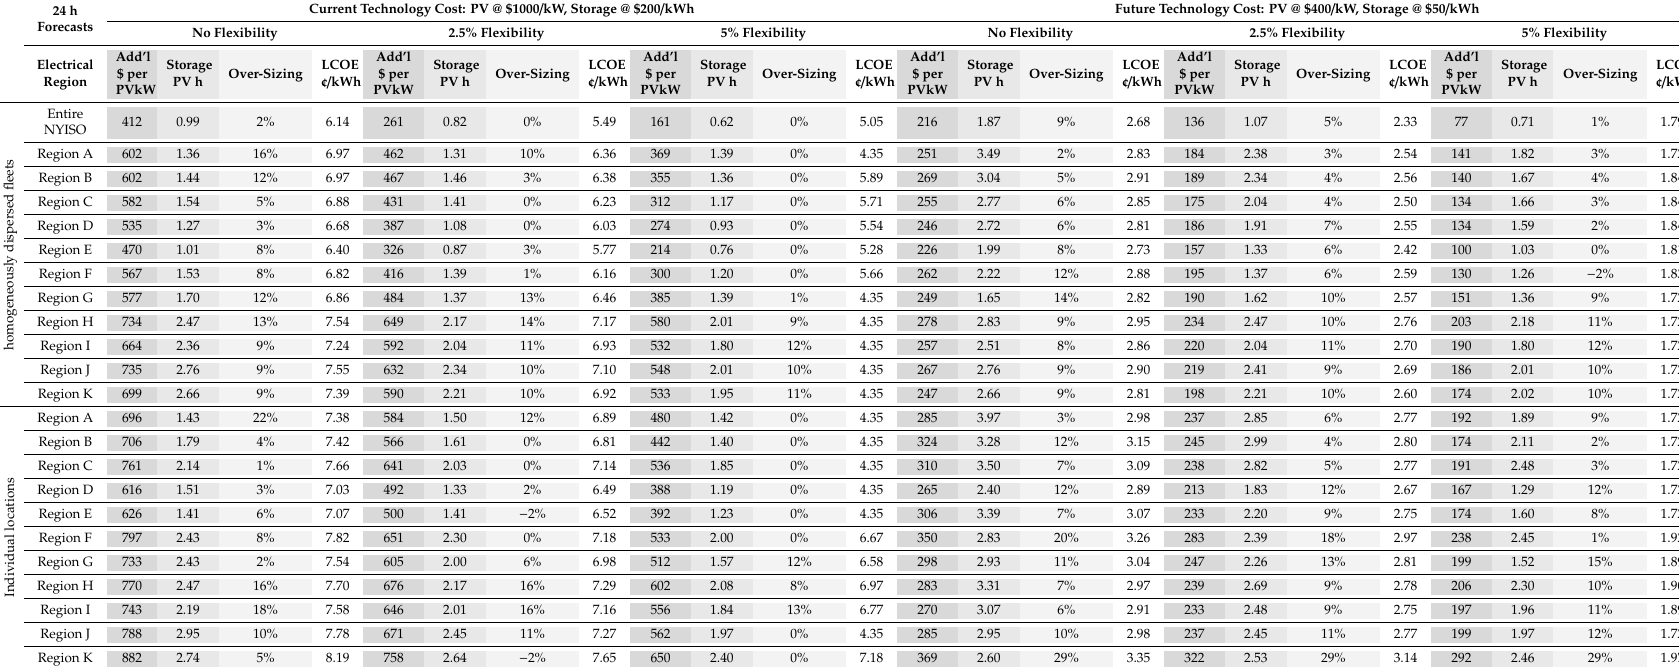
Table 3. Twenty-four-hours-ahead